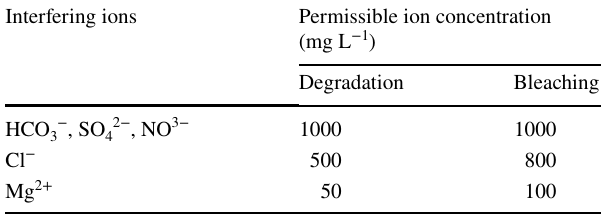
Table 3 The results influence the interference of common ions and permissible